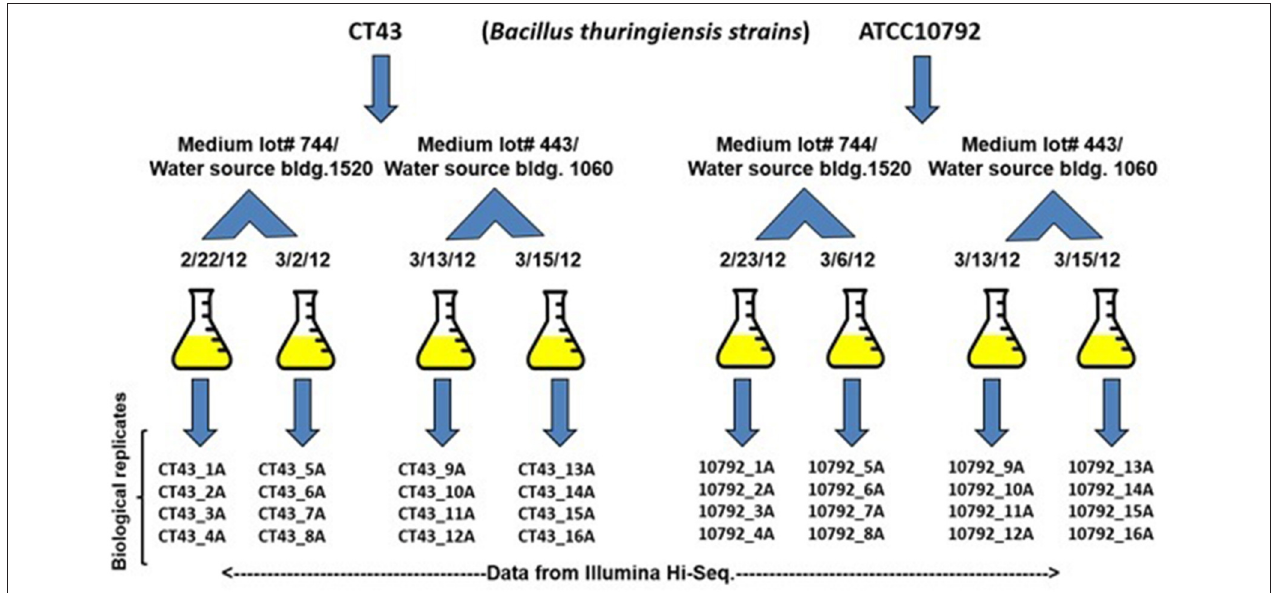
FIGURE 1 | Sampling and major sources of variation. Strains CT43 and ATCC10792 grown in two medium lots #1091744 and 7220443 in water taken from building 1520 and 1610. Bacteria were cultured on four different dates and four biological replicates were grown to mid-log phase for each date, harvested and then RNA-seq data were generated using an Illumina Hiseq 2000 instrument.